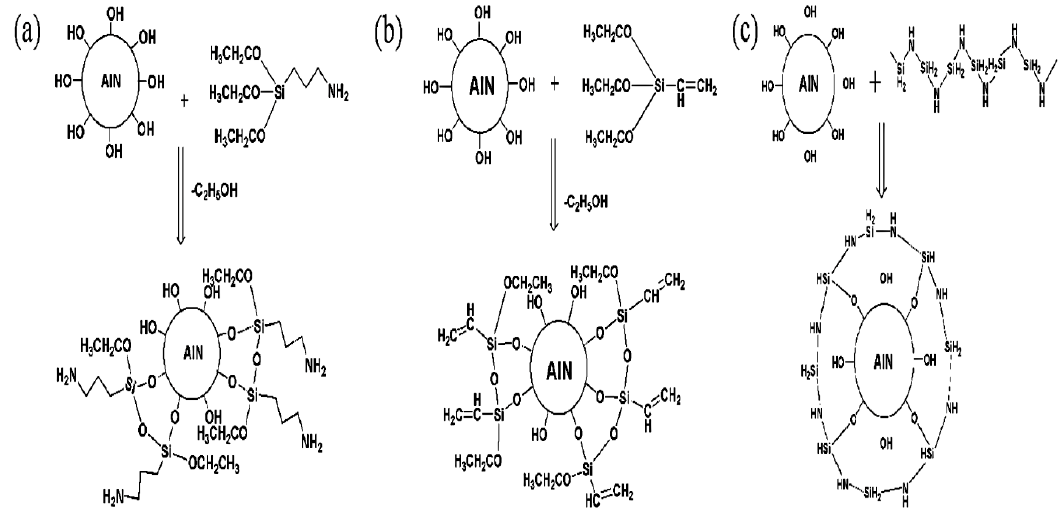
Figure 1. Schematic representation of the surface-treated AlN nanoparticles. ( a ) APTES-AlN, ( b ) VTES-AlN, and ( c ) PSZ-AlN. ( b ) VTES-AlN, and ( c )